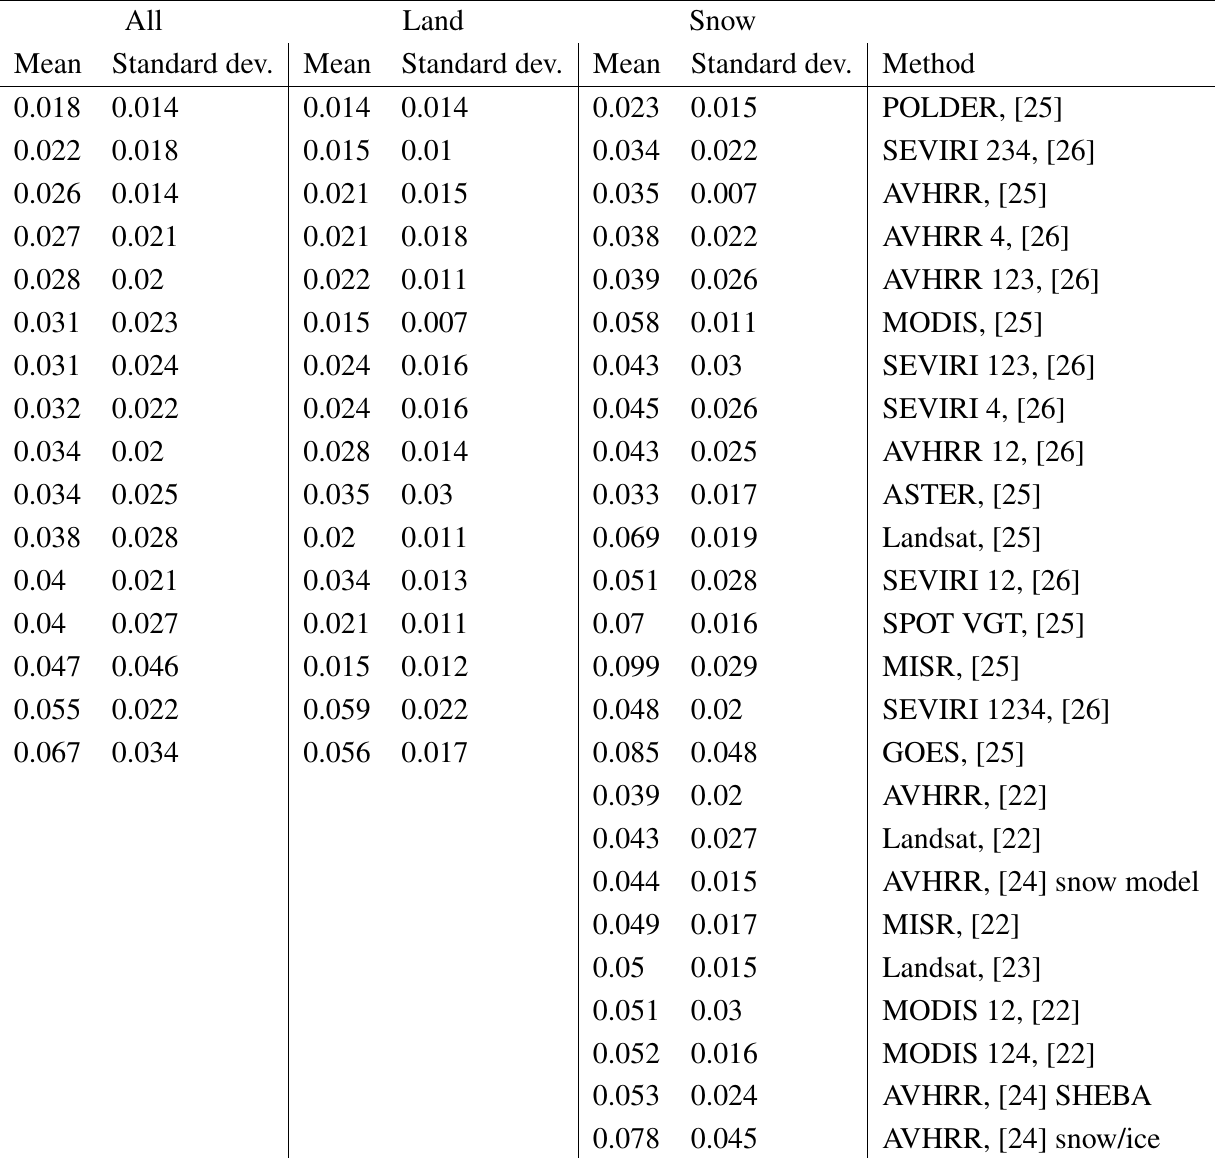
We obtained the mean and standard deviation values of the difference in estimated albedo values as follows (1) by using various broadband conversion formulae; and (2) by directly integrating the measured BRF spectrum. All targets and sun zenith angles are